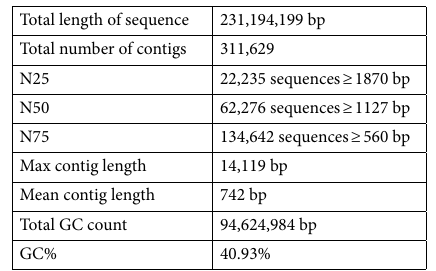
Table 1. Statistics of Trinity transcriptome assembly.